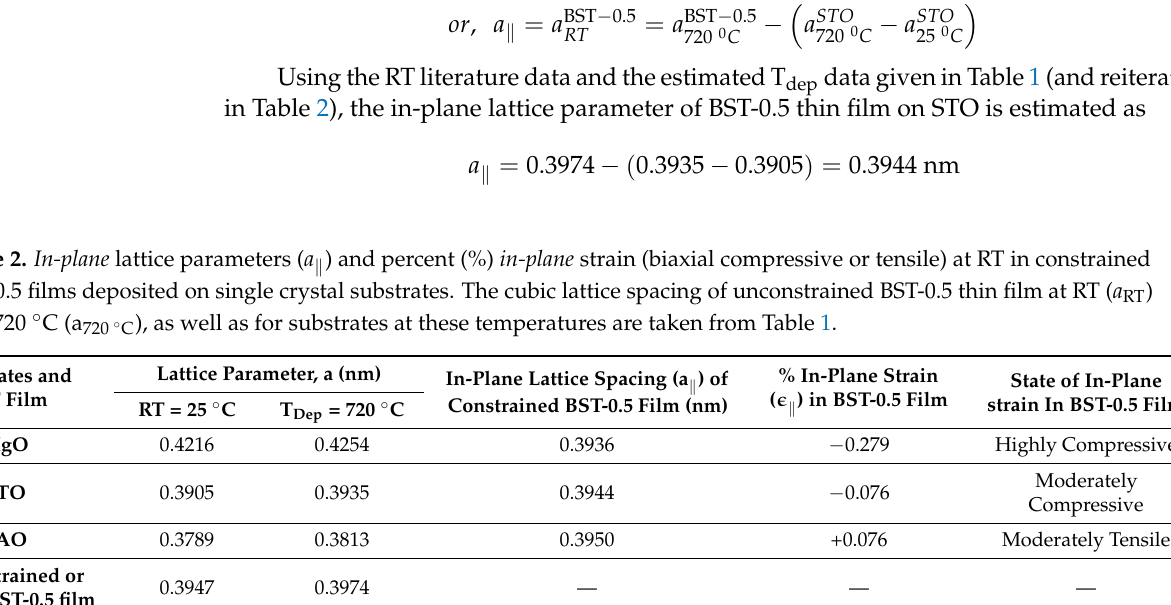
Unconstrained or relaxed BST-0.5